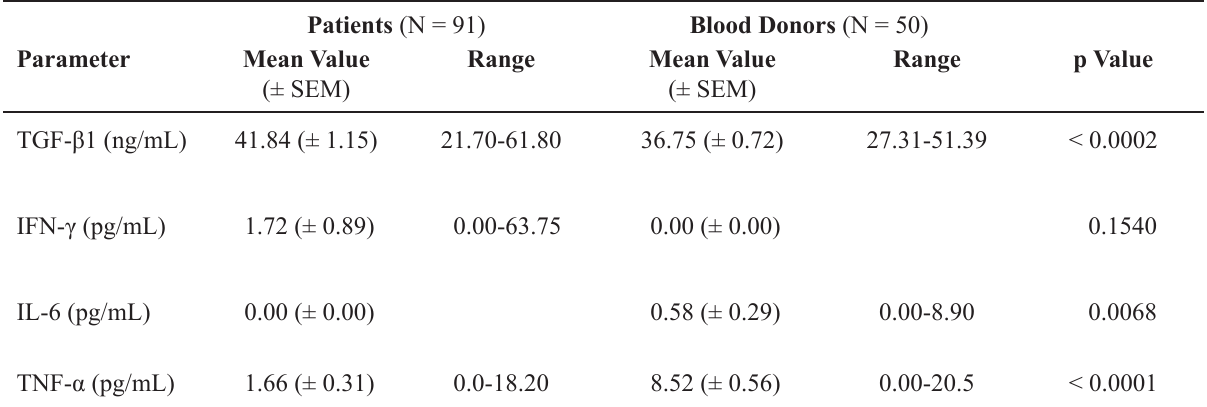
Table 2 – Mean values (± SEM, standard error of the mean) and range of cytokine levels in serum of PD patients and male blood